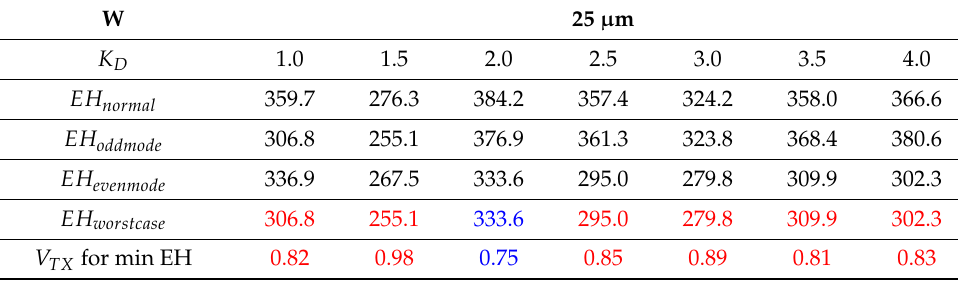
Table 3. Eye diagram simulation results of the microstrip